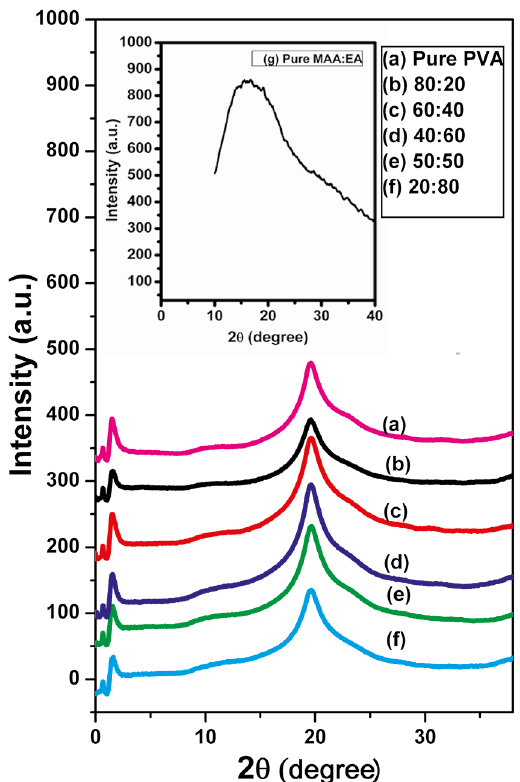
Figure 7. XRD curves of pure and blended PVA/MAA:EA samples (a) Pure PVA (b) 80:20 (c) 60:40 (d) 40:60 (e) 50:50 (f) 20:80 (g) Pure